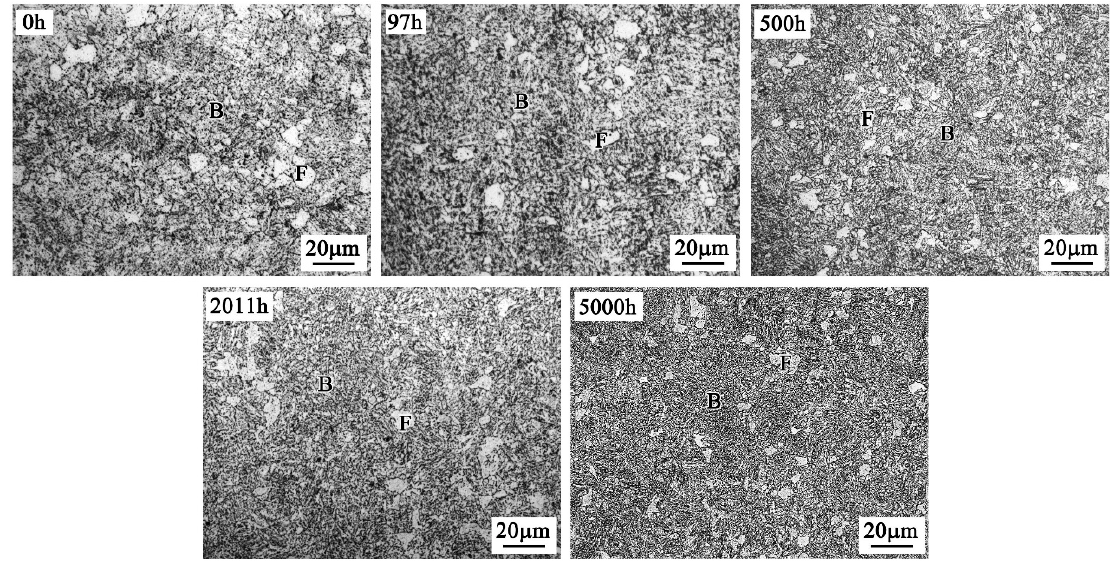
Figure 5. Microstructure and morphology of S1 experimental steel aging for different lengths of time at 580 °C.